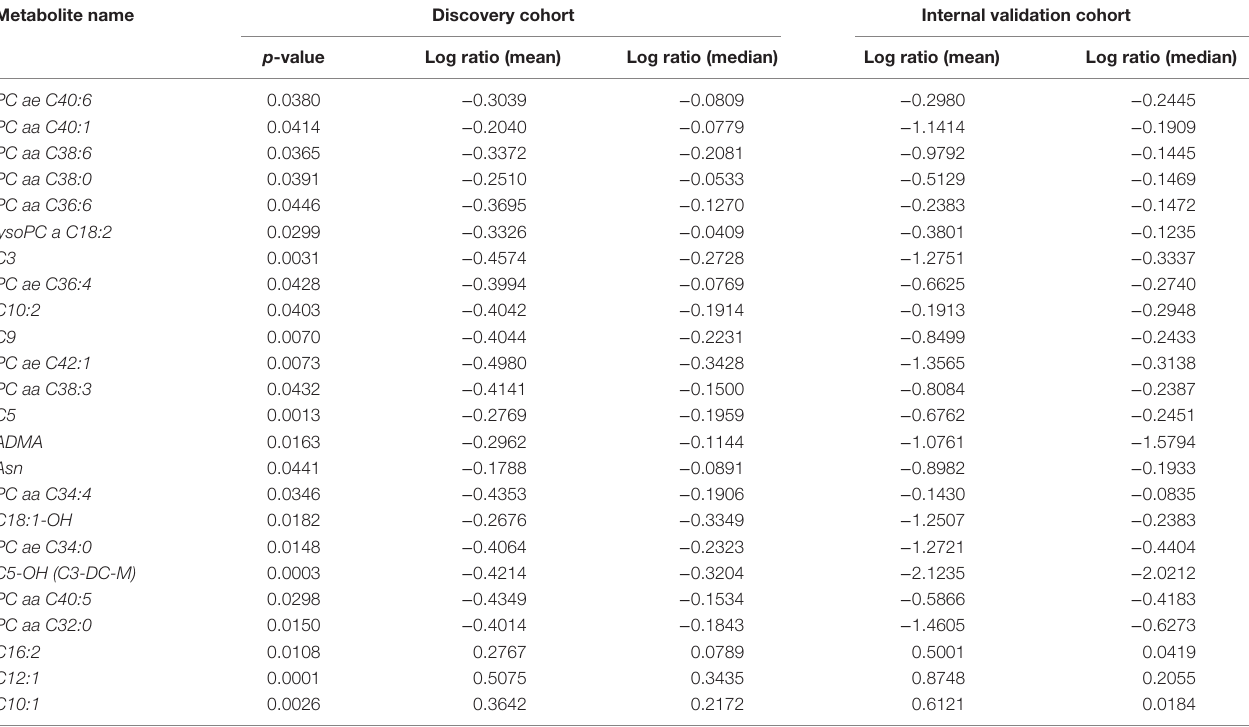
TaBle 3 | components of the 24 metabolite biosignature for determining risk of phenoconversion from normal cognition to aMci or